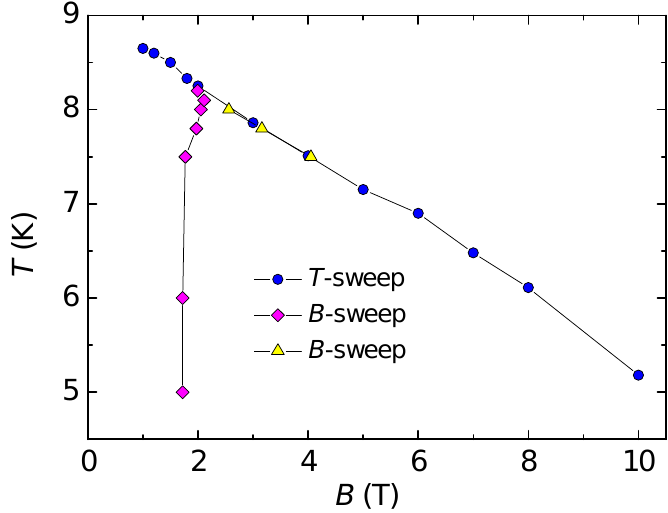
Figure 6. Anomaly diagram for κ -(BEDT-TTF) 2 Cu 2 (CN) 3 (KAF 5078#1) based on the position of the field-induced anomalies in ∆ l b / l b as determined from thermal expansion measurements at B ( (cid:107) b ) = constant ( T -sweep, blue circles) and magnetostriction at T = constant ( B -sweep, magenta diamonds and yellow triangles). We note that these effects are absent in measurements along both the in-plane c -axis with B (cid:107) c and along the out-of-plane a -axis with B (cid:107) a